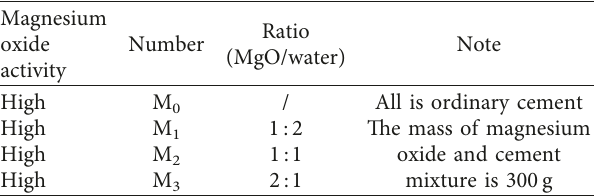
Table 2: Material